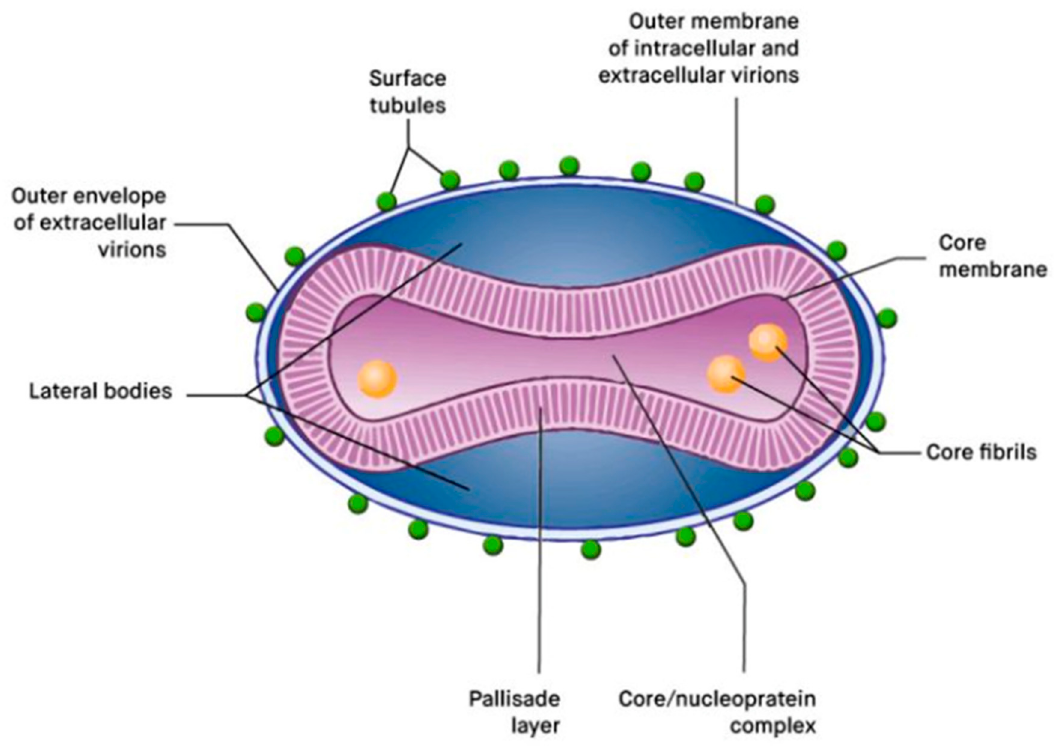
Figure 1. Monkeypox virus. Schematic representation of a poxvirus particle. Adapted from Principles of Molecular Virology , 6th Edition (p. 46), by Alan J. Cann, 2016, UK: Elsevier. Copyright 2016 by Elsevier. License number for the reuse of this figure: 5415960043412.